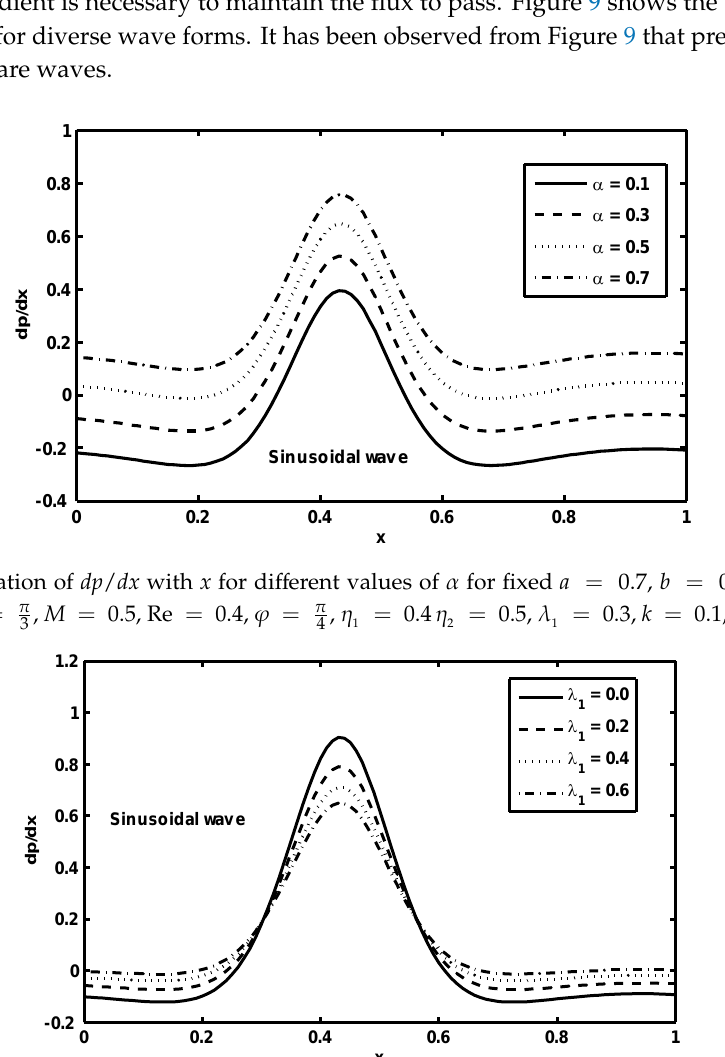
Figure 6. Variation of dp / dx with x for di ff erent values of λ d = 1.5, Θ = π